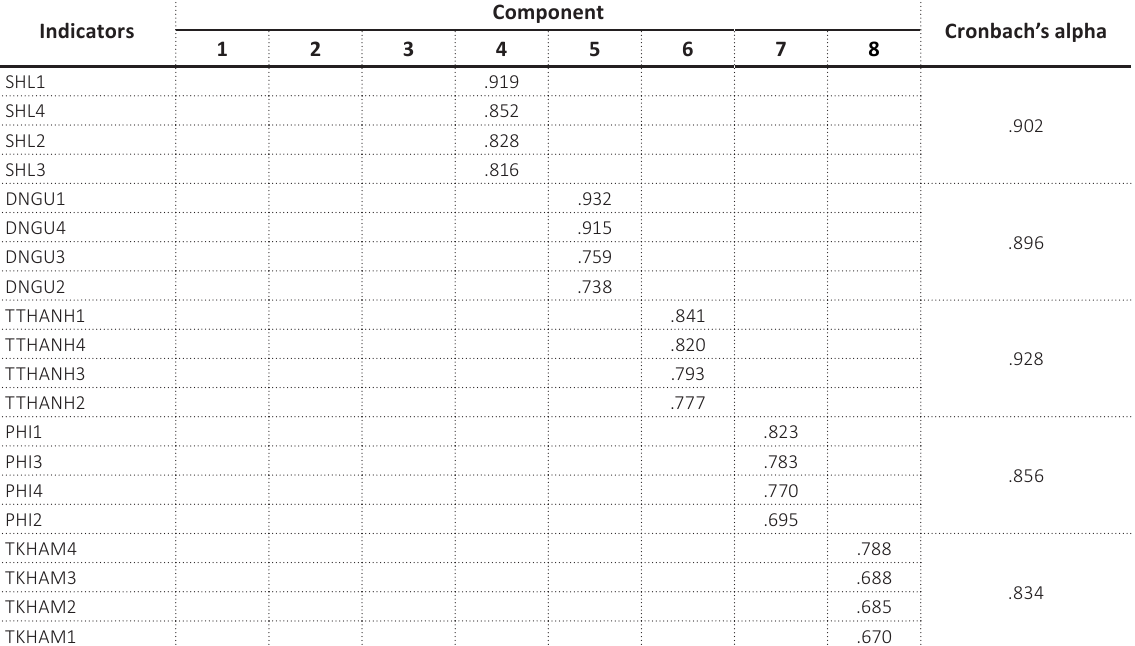
Table 3 (cont.). Rotated component matrix and Cronbach’s alpha